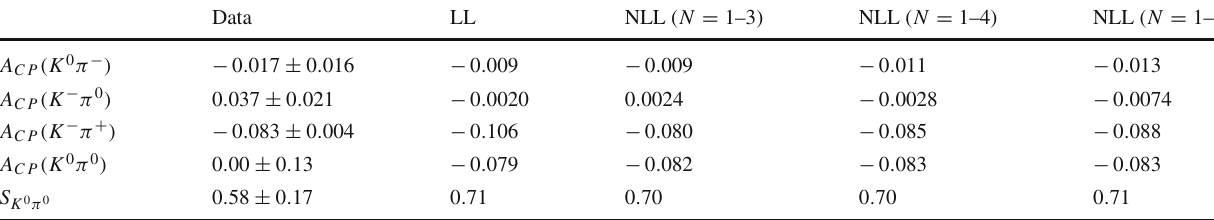
Table 1 Direct and mixing-induced CP asymmetries in the B → K π